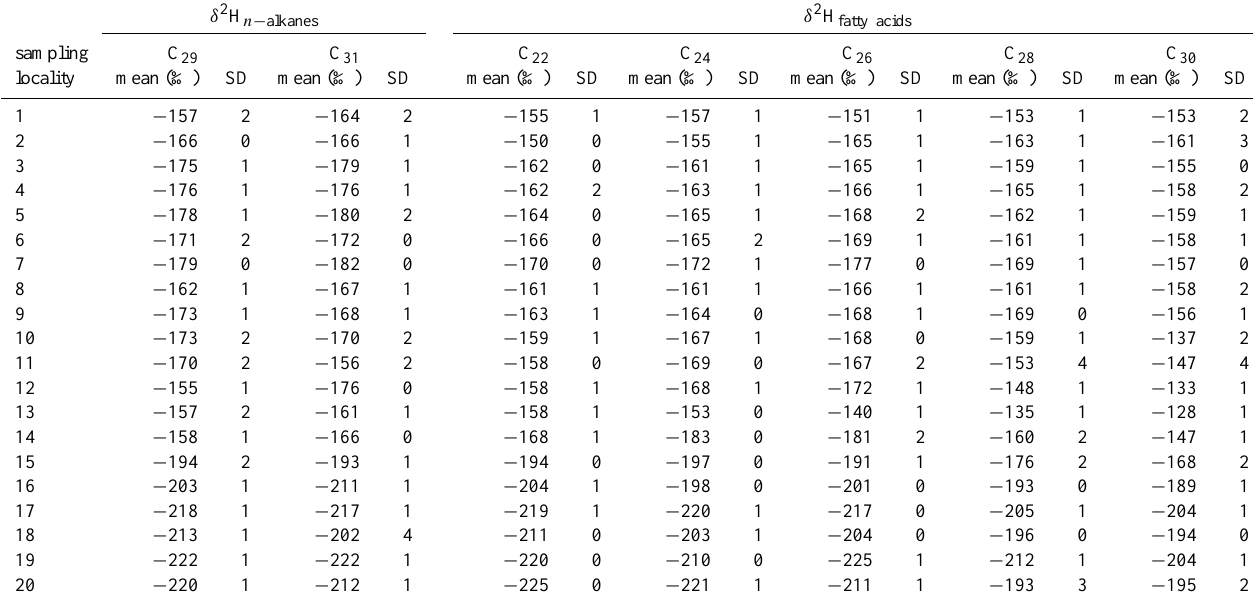
Table 1. δ 2 H values of individual leaf wax n -alkanes and fatty acids. Measurements were carried out in at least triplicate (SD = standard